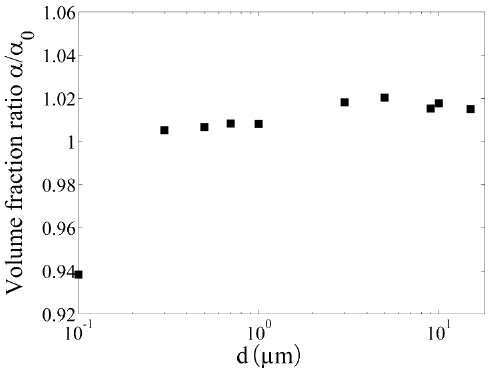
Figure 5. Dependency of the droplet concentration in the sensor probe slit on the droplet size.